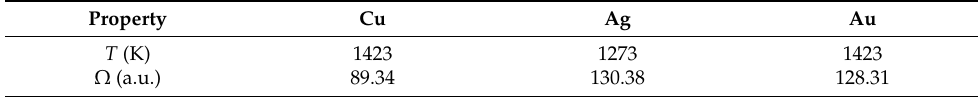
Table 1. Input experimental information.